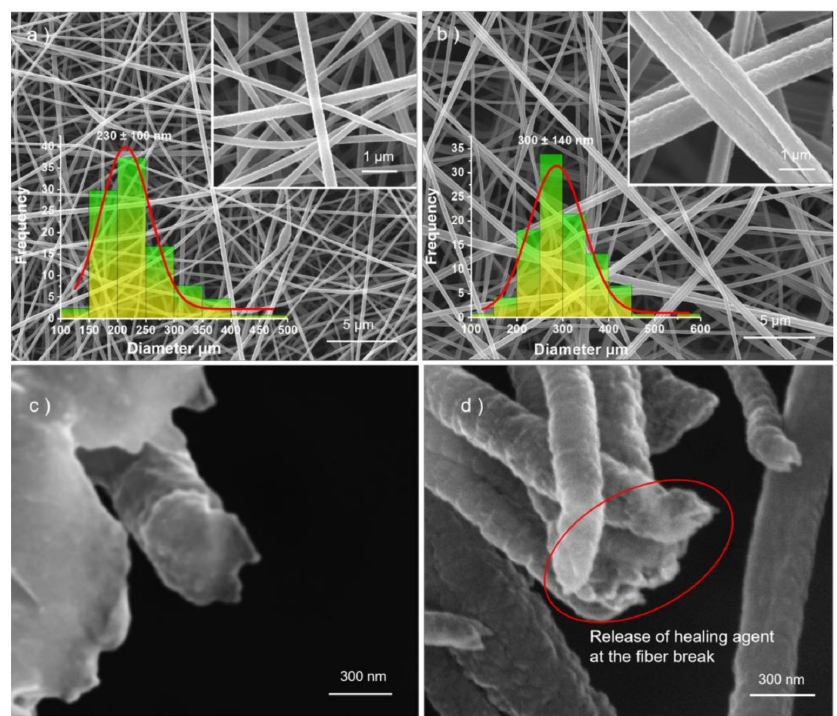
Figure 3. SEM images of fiber distinguished by di ff erent size: ( a ) PAN fibers; ( b ) the special core-shell fibers; ( c ) the broken PAN fibers; ( d ) the reactive healing agent solidifies at the broken core-shell fibers.